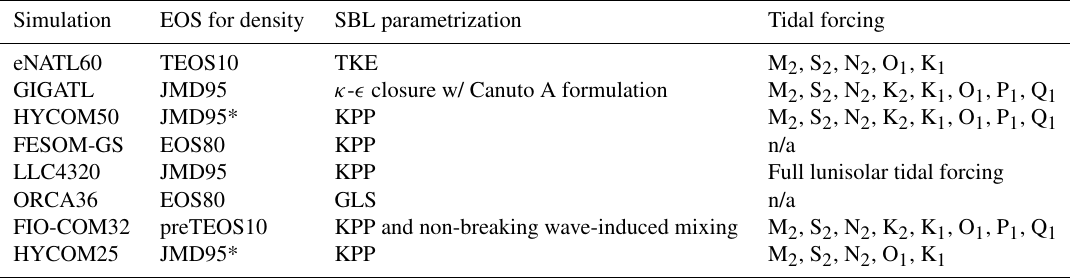
Table B3. The equation of state (EOS), surface boundary layer (SBL) parametrization used, and tidal forcing in each simulation. * Jackett and McDougall (1995, JMD95) in HYCOM is implemented with the approximation by Brydon et al. (1999). The potential densities were computed following each EOS with the reference pressure of 0dbar (Fernandes, 2014; Abernathey, 2020; Firing et al., 2021). The EOS for FIO-COM32 is available on Github (Stern et al., 2022b, https://github.com/pangeo-data/swot_adac_ogcms, last access: 8 July 2022). Note that FESOM-GS and ORCA36 do not have tidal forcing, whilst the others have at least the leading five tidal forcings.